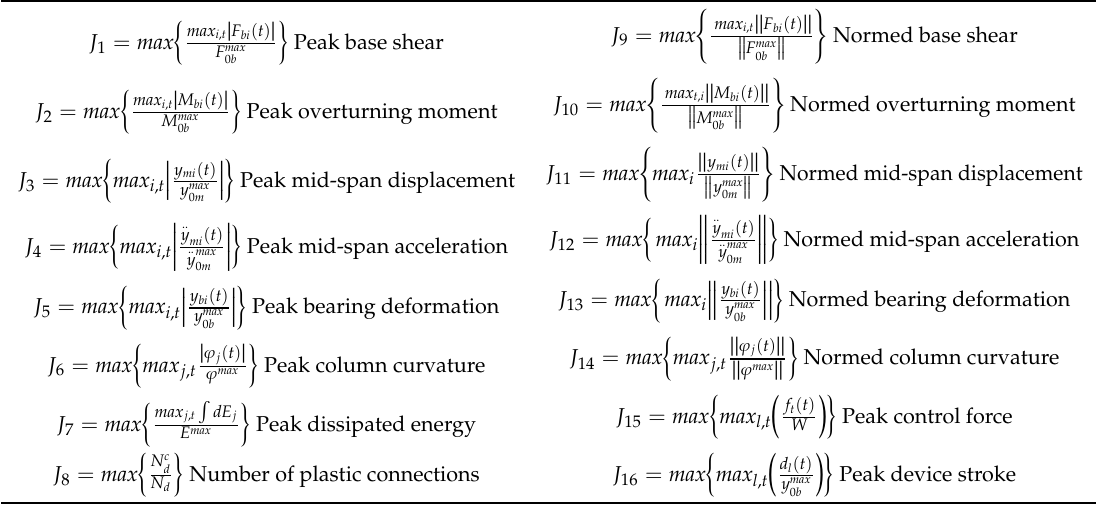
Table 2. Summary of the evaluation criteria.